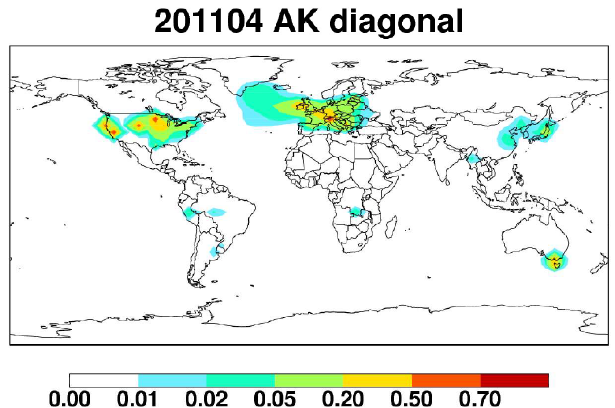
Figure 5. Averaging kernel diagonal values for April 2011 in the SVD-based inversion, calculated from Eq.